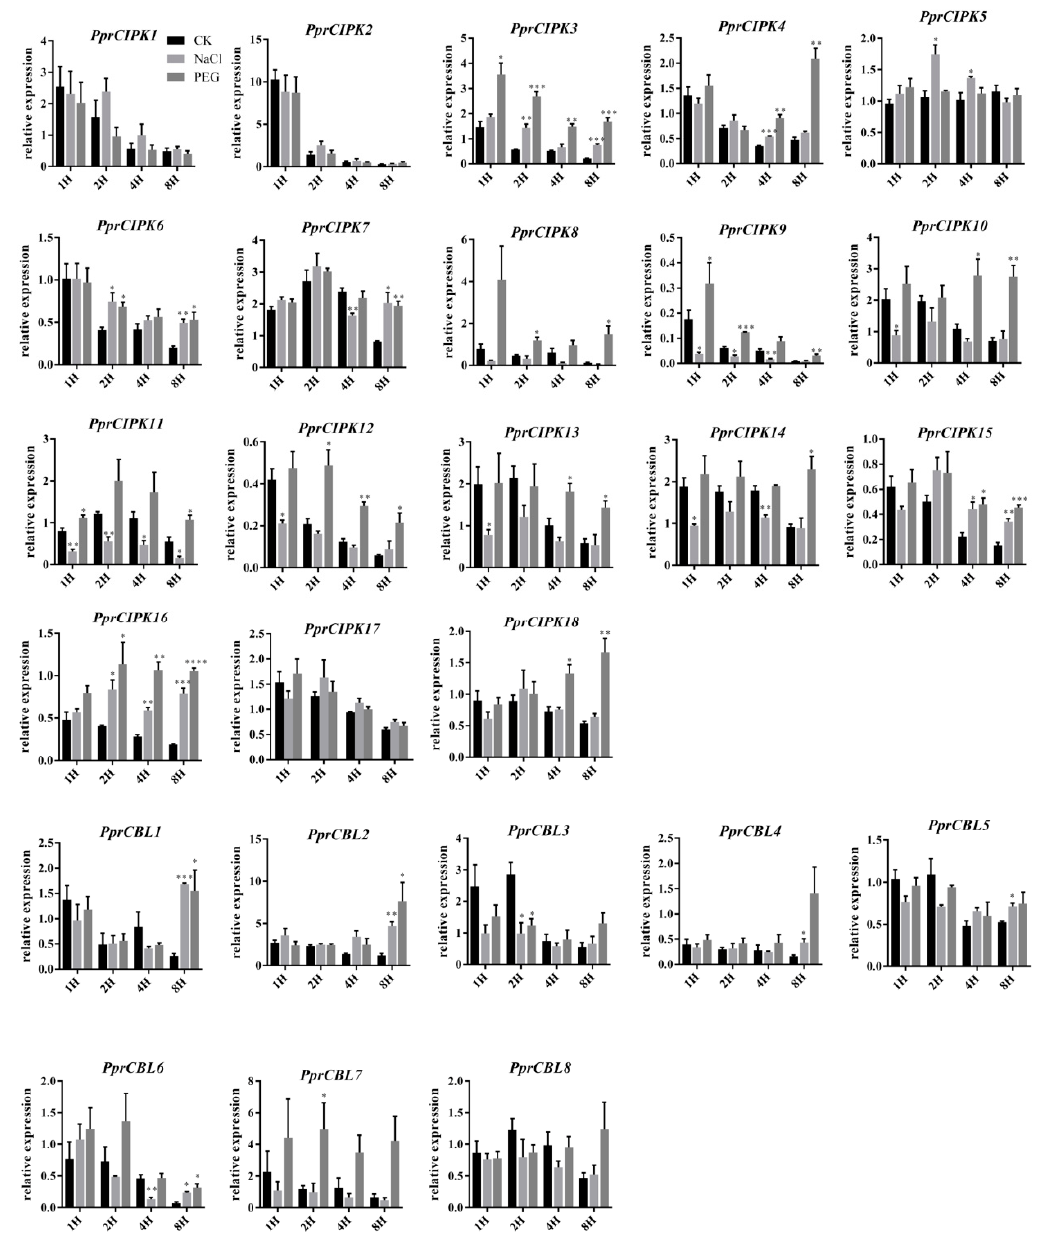
Figure 6. Expression patterns of the peach CBL and CIPK genes in the leaves of cv. “Li Xia Hong” under salt and drought stresses. The x -axis represents the treatment time. The y -axis represents the expression of CBL and CIPK members relative to mRNA abundance at 0 h after treatment. The error bars represent the ± SE of three biological replicates. Asterisks denote significant differences between salt or drought stress and the control by Student’s t test ( p ≤ 0.05).